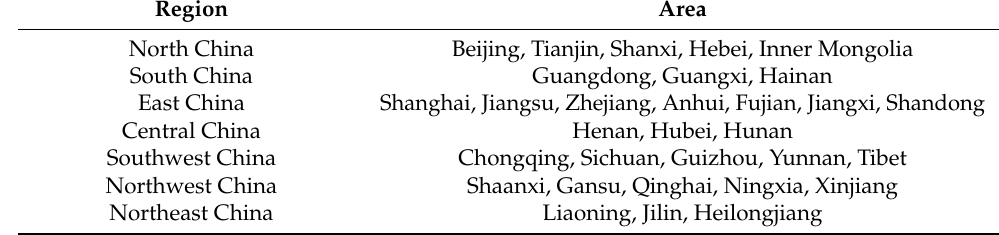
Table 2. Geographical information of seven administrative regions in China.